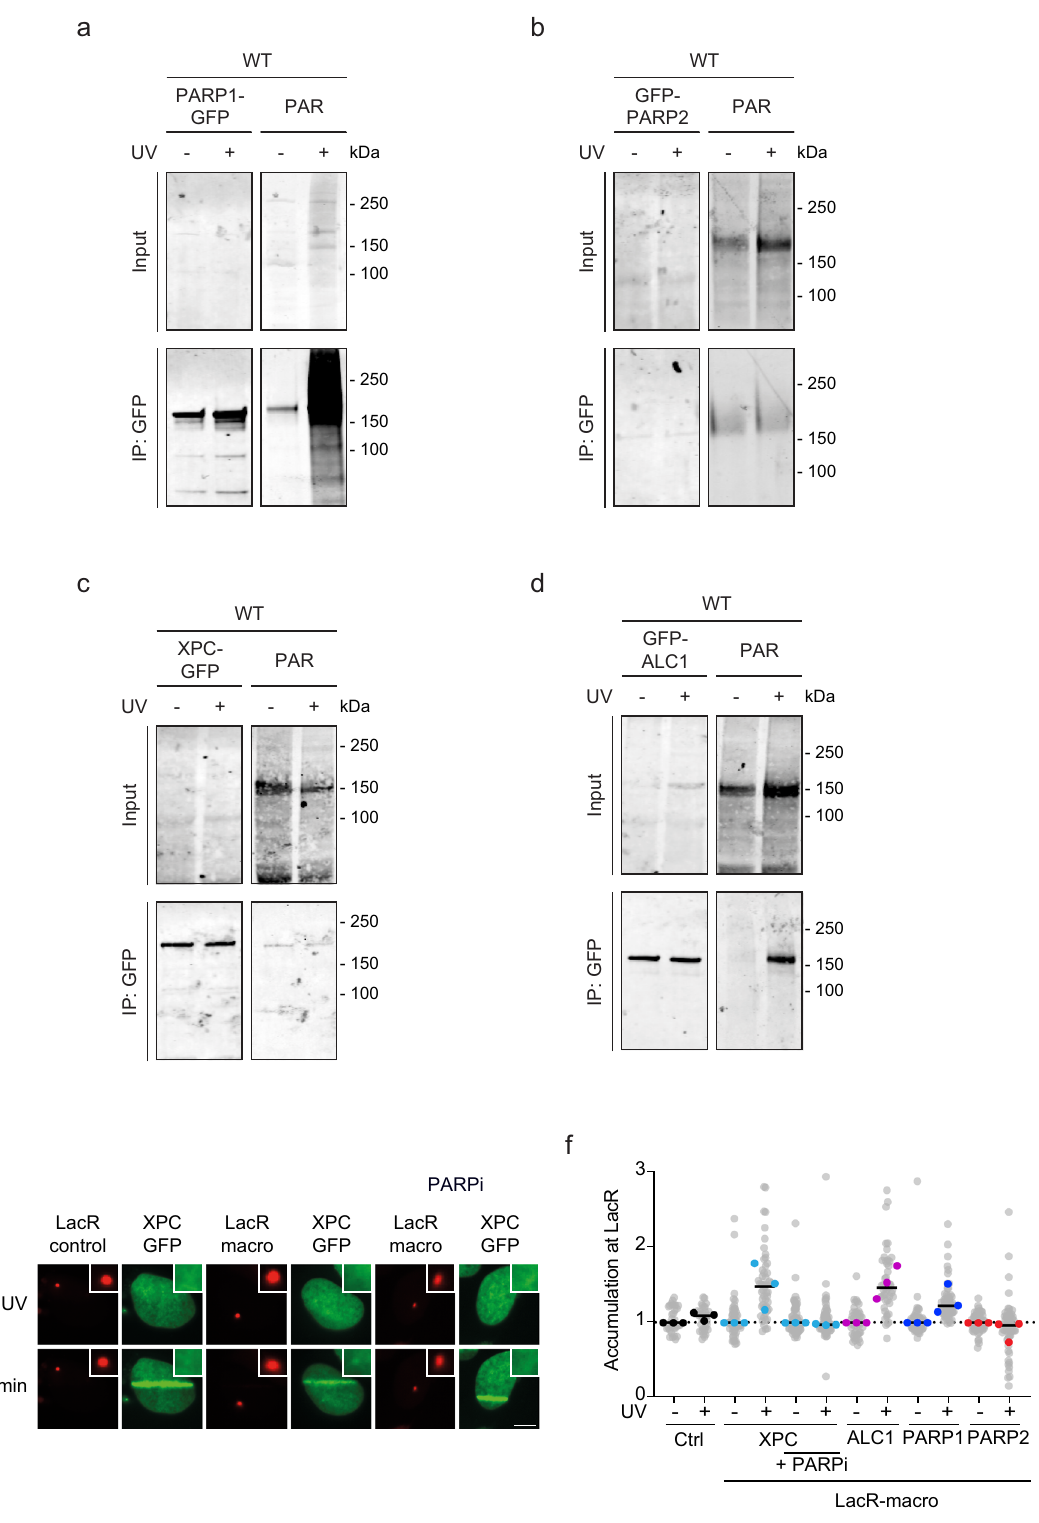
Fig. 5 PARP1 and ALC1 are PARylated in response to UV. a – d Immunoprecipitation of a PARP1-GFP, b GFP-PARP2, c XPC-GFP, d GFP-ALC1 under high- salt conditions in the presence and absence of UV-C (20 J/m 2 , 15 min) stained for PAR (Millipore; MABE1016) or GFP. Three independent replicates of each IP experiment were performed obtaining similar results. e Representative images and f quanti fi cation of GFP-tagged XPC, ALC1, PARP1, or PARP2 recruitment to the LacO array upon tethering to the indicated mCherry-LacR-macrodomain. Pictures were taken before and 1 min after UV-C micro- irradiation. 24 – 45 nuclei were analyzed in three independent biological replicates ( n = 3). Additional representative images are found in Fig. S3a. The scale bar in e is 5 µ